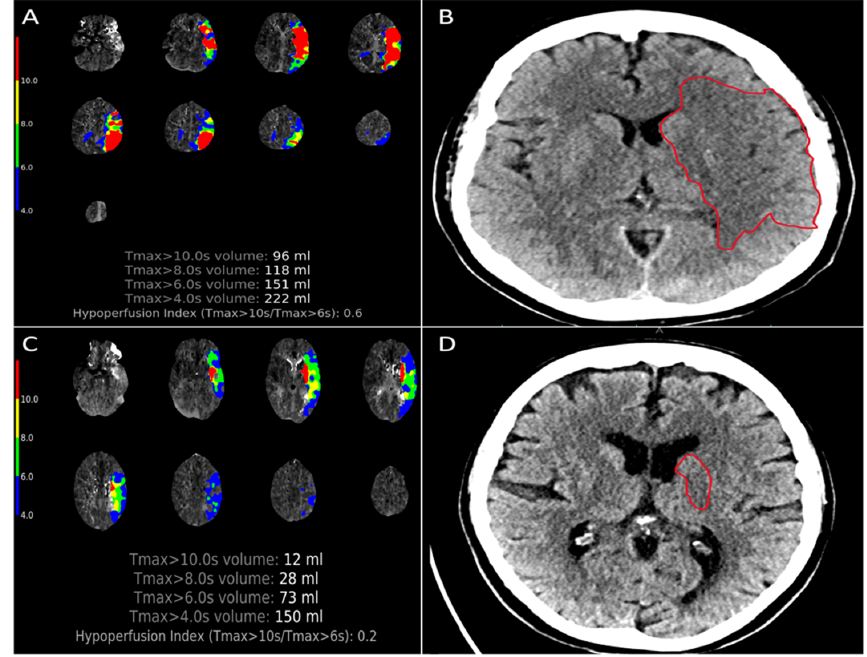
Figure 2. Imaging example of early edema progression in two patients with poor and favorable HIR. Two patients with comparable large vessel occlusion (proximal M1 occlusion) were both treated by endovascular thrombectomy. A 67-year old male patient ( A , B ) with symptom onset 2 h before admission imaging showing unfavorable HIR profiles (HIR = 0.6) and a considerable large baseline infarct hypodensity on non-contrast head CT (marked by the red field in ( B )). The early edema progression rate was calculated at 5.18%/hour for this patient. A 71-year old female patient ( C , D ) who was last seen well 3.2 h before admission imaging exhibited only small infarct hypoattenuation in the basal ganglia (marked by the red circle in ( D )), showing a favorable HIR profiles of 0.2 on admission perfusion imaging. The related early edema progression rate for this patient was calculated at 0.48% per hour. Table 2. Presentation imaging details and clinical outcome dichotomized by the hypoperfusion intensity ratio a